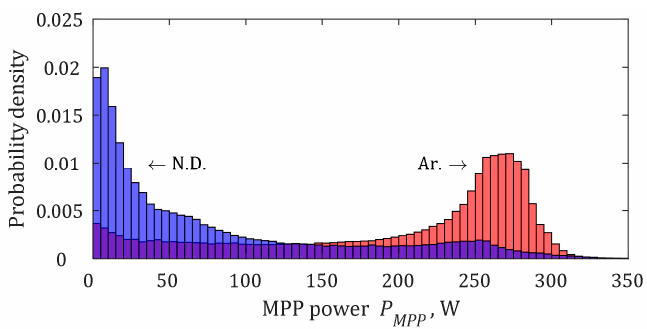
Figure 13. Density distribution of the MPP voltages.